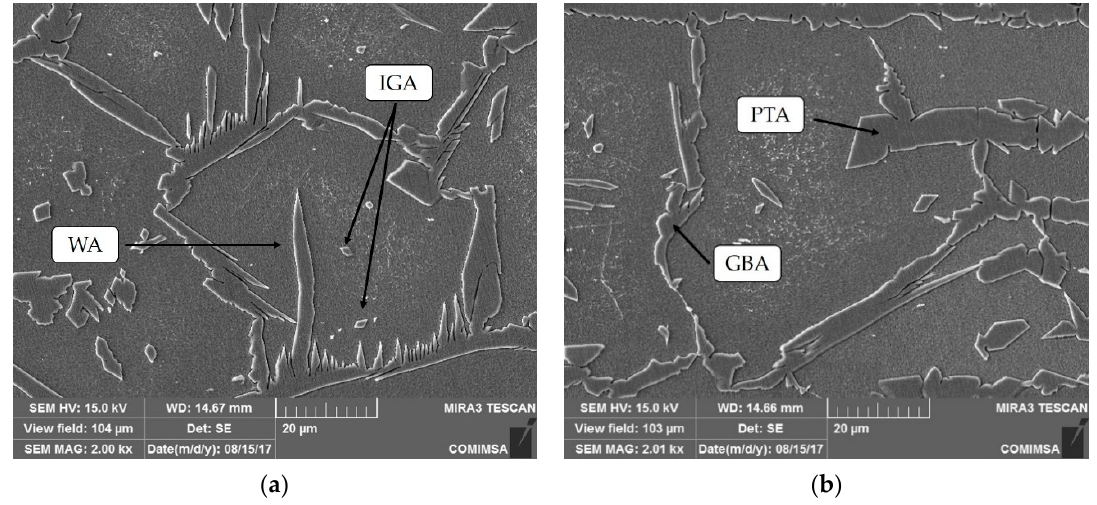
Figure 9. SEM micrographs of the heat-affected zone: ( a ) lean duplex stainless steel (LDSS) 2304; and ( b ) SDSS 2507. WA: Widmanstätten austenite; IGA: intragranular austenite; PTA: partially transformed austenite; GBA: grain boundary austenite. Table 8. EDS analysis (wt. %) of the phase proportions in the heat-affected zone.